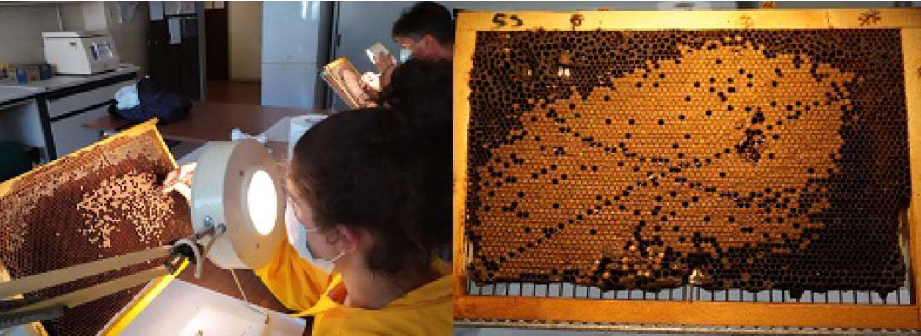
Figure 2. Evaluation of effectiveness of hyperthermia by counting the number of live and dead individuals of Varrosa destructor present in the cells.